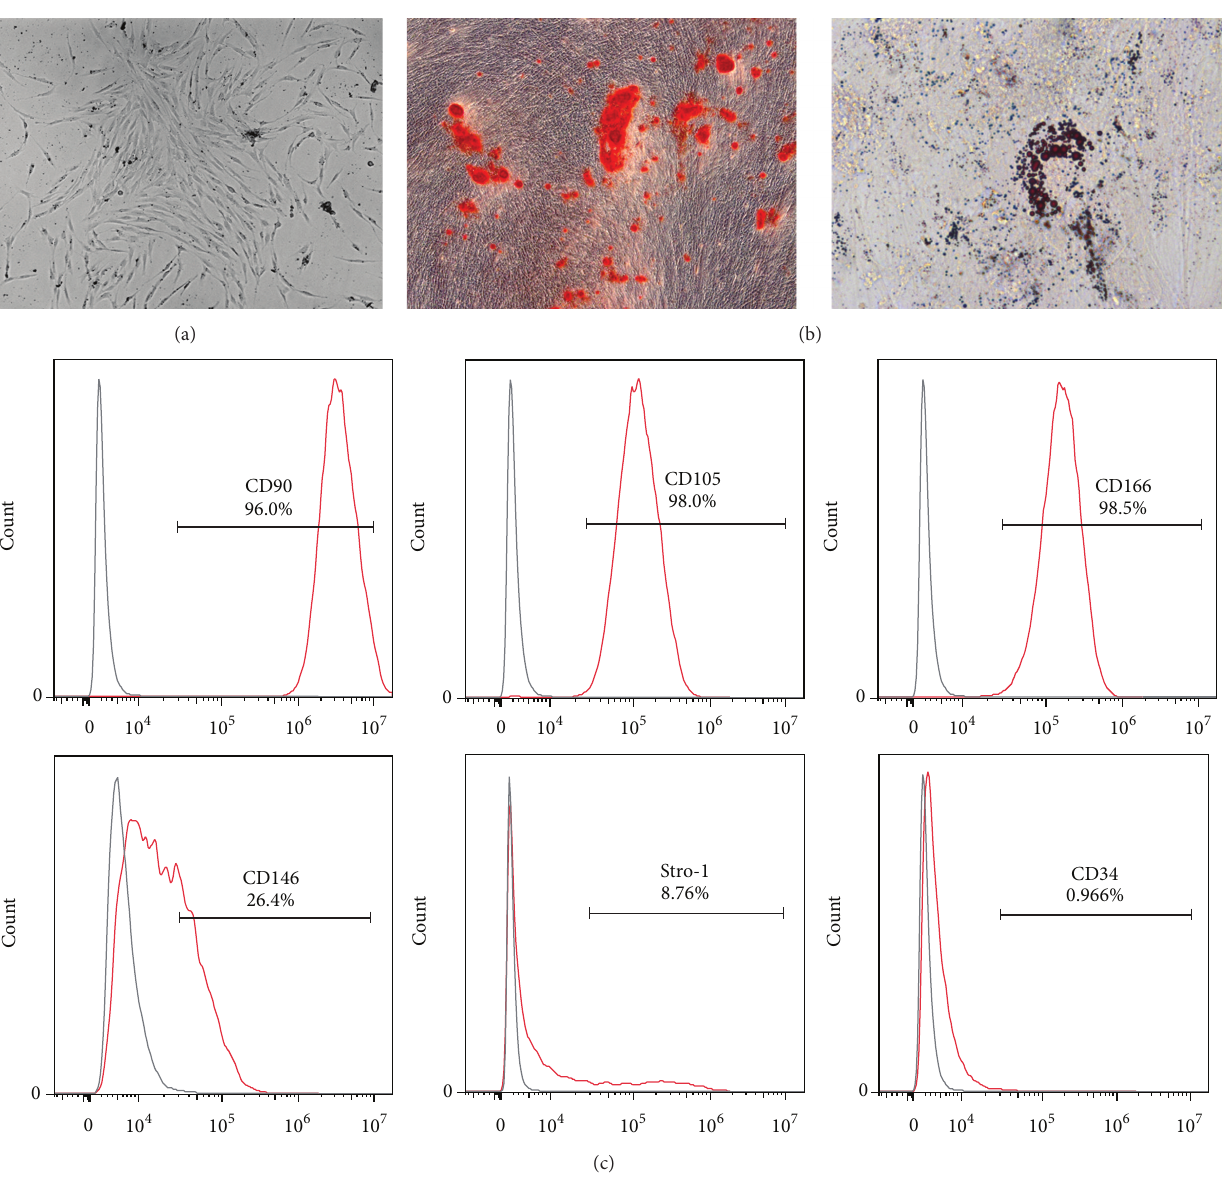
Figure 1: Characterization of hPDLSCs. (a) The morphology of colony-forming hPDLSCs (magnification: 50x). (b) Differentiation potential of hPDLSCs. Differentiated cells were stained with Alizarin red (left; magnification: 100x) or Oil Red O (right; magnification: 630x). (c) Immunophenotypic profiling was performed to detect CD90, CD105, CD166, CD146, Stro-1, and